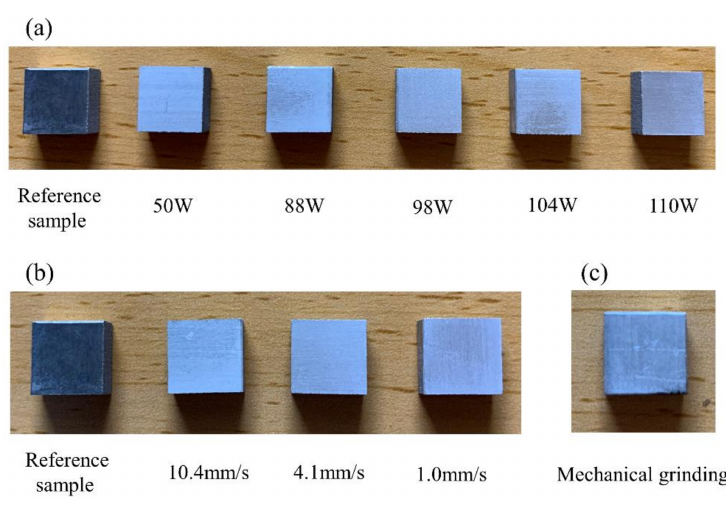
Figure 8. Macroscopic picture of cleaning e ff ect: ( a ) Cleaning e ff ect under di ff erent powers; ( b ) cleaning e ff ect at di ff erent speeds; ( c ) mechanical